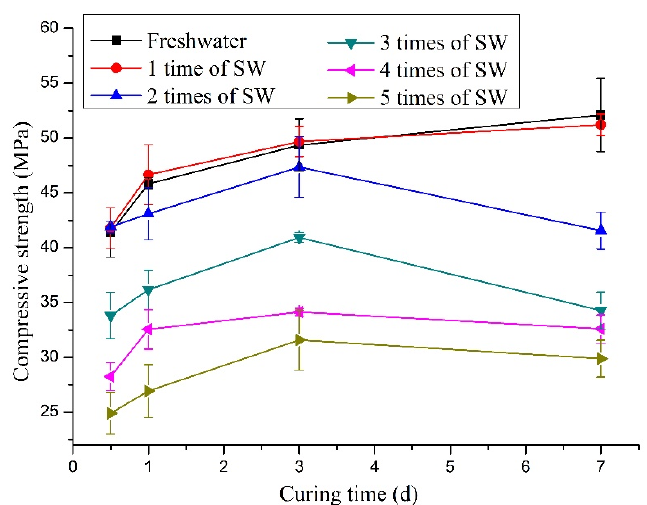
Figure 5. The strength development of CSA cement mixed with seawater at different concentrations.